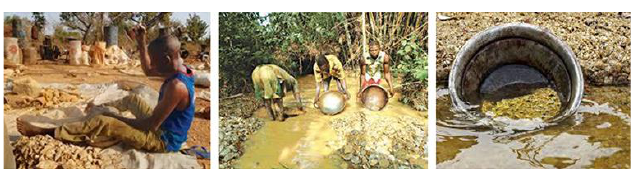
Figure 1: Death in the Goldmines (Source: vangaurdngr.com)